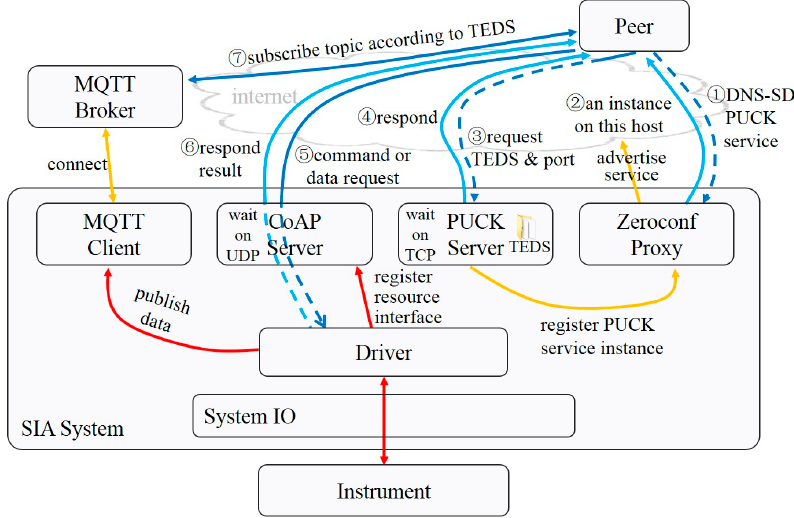
Figure 6. Interoperable communication scheme with MQTT broker.